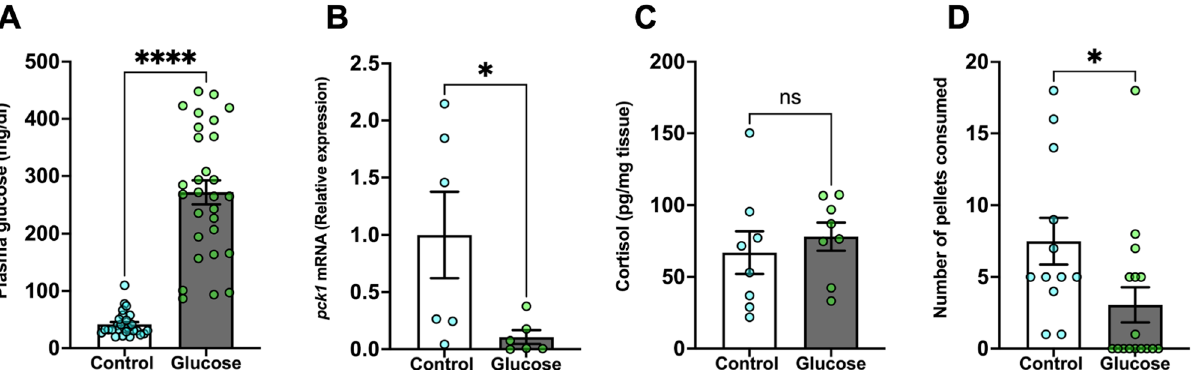
Figure 1. Glucose exposure inhibits food intake. ( A ) Plasma glucose was significantly higher in the glucose- treated fish compared to the control fish. ( B ) pck1 transcript abundance in the liver significantly decreased after glucose treatment compared to the control fish. ( C ) Whole-body cortisol levels remained unchanged in the glucose-treated fish compared to the control fish. ( D ) Glucose-treated fish consumed significantly fewer pellets than the control. Values are means ± SEM. (Plasma glucose n = 27–29; Transcript abundance n = 6; Whole-body cortisol n = 8; Feeding performance n = 12–16). ns—not significant; *( P < 0.05); ****( P < 0.0001)).